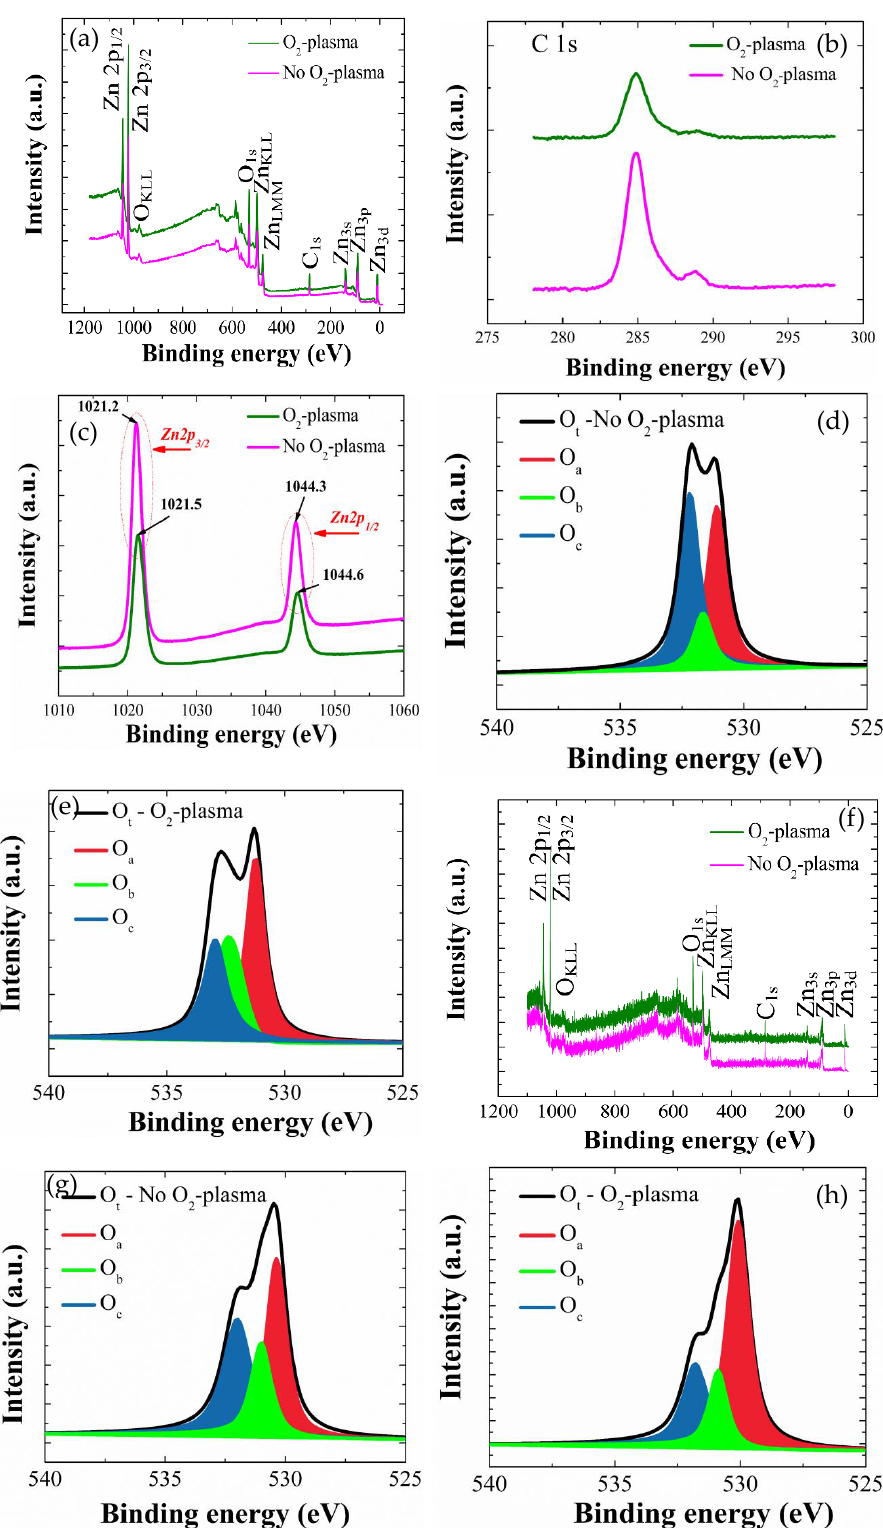
Figure 6. ( a ) XPS wide scan spectra of as-deposited and O 2 -plasma-treated (for 9 min) SLs with high-resolution individual core level spectra of ( b ) C-1s and ( c ) Zn-2p. O-1s spectra obtained from the as-coated and plasma-treated (for 9 min) SLs are also shown in ( d ) and ( e ); ( f ) Wide scan spectra of the ZnO NRs grown on as-deposited and O 2 -plasma-treated (for 9 min) SLs with high-resolution O1-s core level spectra of the NRs grown on ( g ) as-deposited and ( h ) O 2 -plasma-treated (for 9 min) SLs. High-resolution O-1s photoelectron peaks from the as-coated and O 2 -plasma-treated SL crystals were depicted in Figure 6d,e, respectively. Gaussian peak deconvolution for the O-1s curve gives three distinct satellite peaks of O a , O b , and O c . O a is a peak at the lowest energy of 530.4 eV which is originated from the O 2− ion in the wurtzite structure of hexagonal ZnO [12]. Since O a comes from the stoichiometric oxygen present in the wurtzite structure, we can evaluate the ZnO stoichiometry from ∫O a /∫Zn from each SL crystal as summarized in Table 2, where ∫O a and ∫Zn respectively represents the peak curve integration of Oa and Zn in XPS spectra. The percentage contribution of O a in O t (O t = O a + O b + O c ) can be also obtained by ∫O a /∫O t , and this contribution of stoichiometric oxygen in total oxygen of ZnO was increased from 37.1% (reference SL) to 61.5% when the SL crystals are plasma treated. This reveals the effectiveness of our O 2 plasma treatment for the injection of stoichiometric oxygens into ZnO wurtzite structure. Table 2. Percentage values of the XPS O-1s satellite peaks from as-coated and O 2 -plasma-treated (for 9 min) SLs and NRs grown on each SL crystal. Each percentage value was calculated by dividing the curve integration of individual satellite peak by the curve integration of total peak. Condition 0.91 The percentage contribution of each de-convoluted peak was also calculated from the integration of individual curves in O-1s peak and summarized in Table 2. It is common that the ZnO grows in an oxygen-deficient state caused by a high density of oxygen vacancies; however, the O a /Zn ratio was increased from 0.61 (reference) to 0.86 when the SLs are plasma treated due to the effectiveness of oxygen injection. The percentage of O b , which is the peak at a middle energy of 531.1 eV, was also increased from 11.2% to 21.1%, and this result is thought to be associated with the injected-oxygen participation into O 2− ions in the oxygen-deficient region of the ZnO matrix [12,25,26]. Finally, O c is the peak at the highest energy of 532.1 eV, and it has a strong relationship